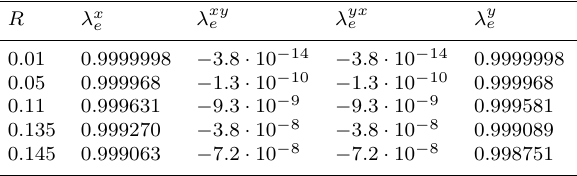
Table 5. The components of the effective conductivity tensor Λ e for the configuration of the inclusions given in (4.1) for the material constants λ k = 0 . 01, γ k = 100, β k = − 100, M = 9. R λ x e